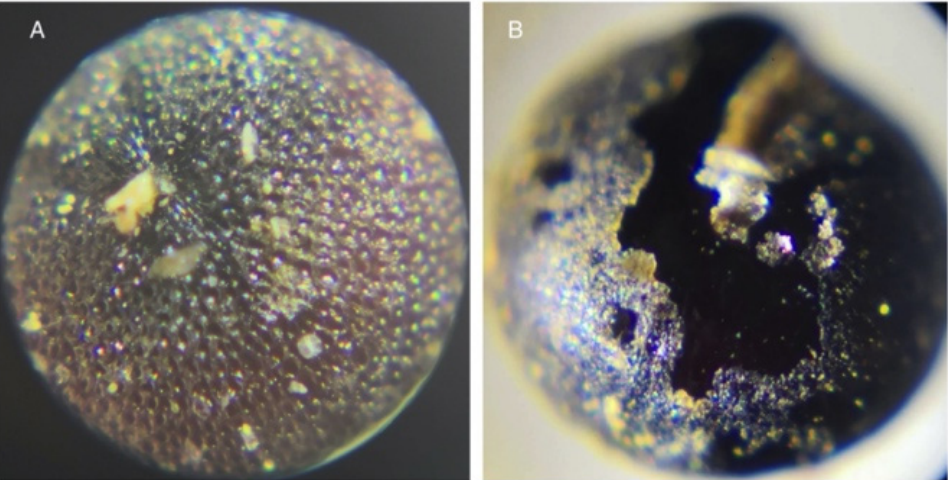
Figure 3. Wild quinoa relatives’ seed surfaces. ( A ) Probably C. quinoa ssp. milleanum, or C. berlandi- eri , or C. hircinium , with a pitted surface. ( B ) Probably C. album , with a smooth surface. Magnitude: 60 × . Photos: L. Hinojosa.